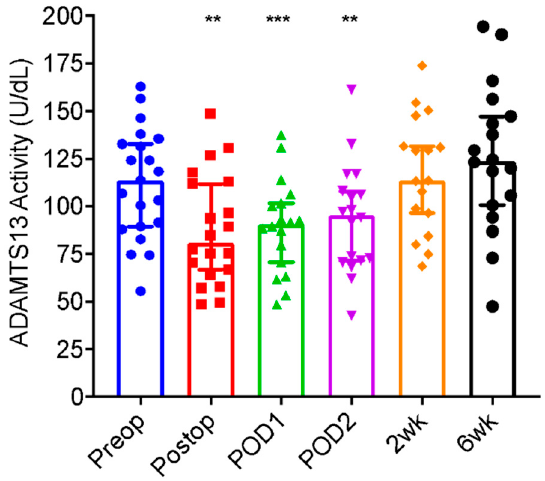
Figure 1. ADAMTS13 (A Disintegrin And Metalloprotease with Thrombospondin type 1 repeats, 13) activity in patients before and after Joint Arthroplasty. Plasma levels of ADAMTS13 activity in patients before (Preop), immediately (postop), one day (POD1), two days (POD2), two weeks (2 wk), and six weeks (6 wk) after elective joint arthroplasty. Each dot represents a result from each patient. The vertical bars are the medians (±95% confidence interval). Here, **, and *** indicate p < 0.01 and 0.001, respectively.